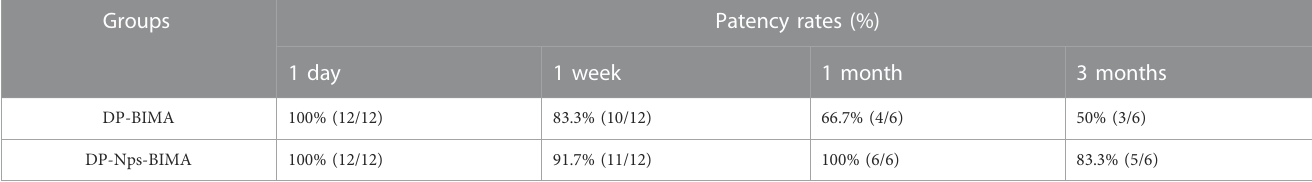
TABLE 3 The patency rates of different time points.